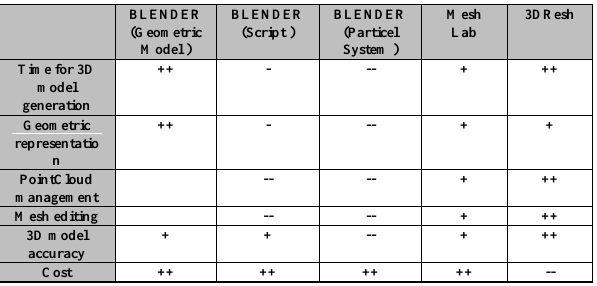
Table 1. A comparison of the achieved 3D models using the different software